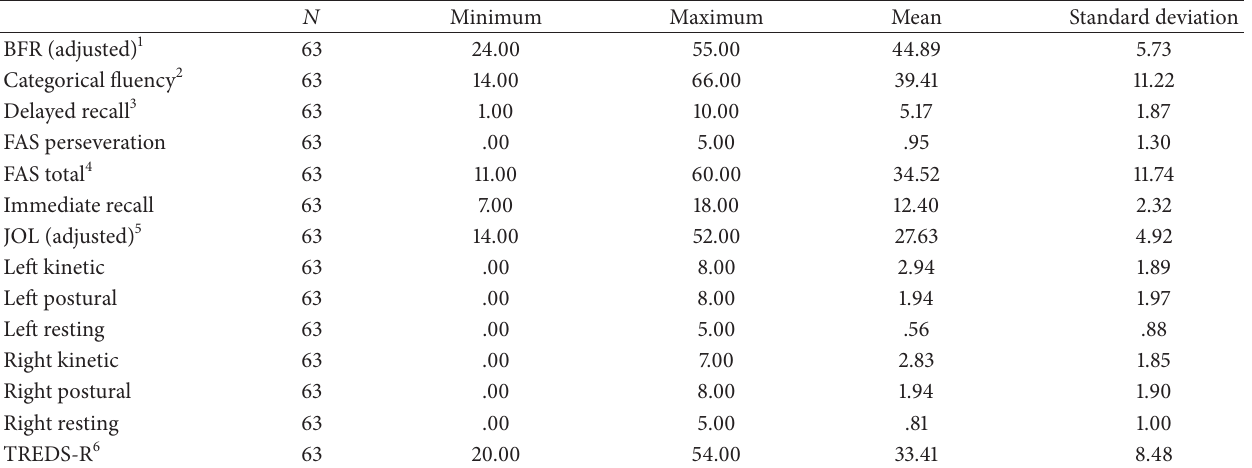
Table 1: Descriptive statistics for measures of cognition, tremor severity, and tremor disability.